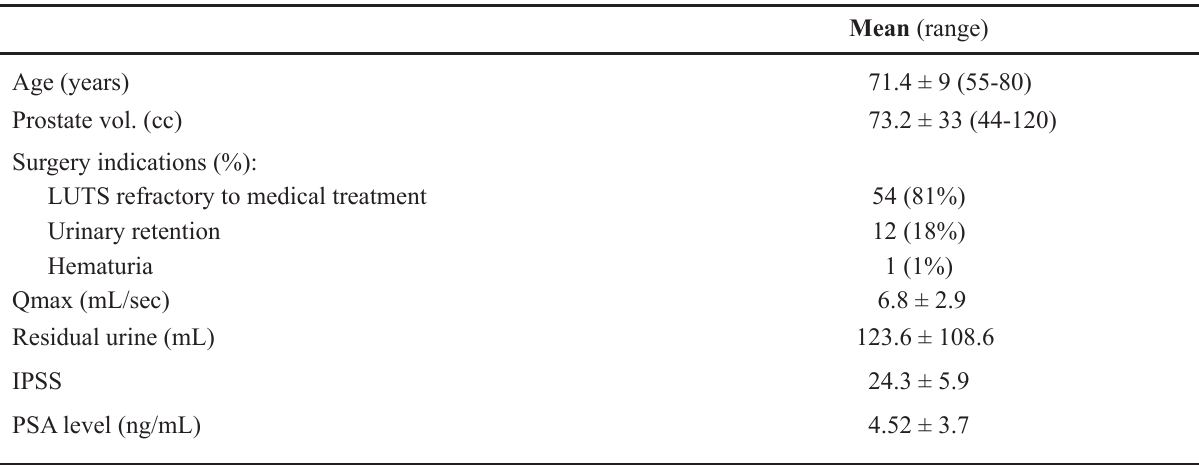
Table 2 – Baseline characteristics and preoperative parameters in patients who underwent photoselective vaporization of the prostate